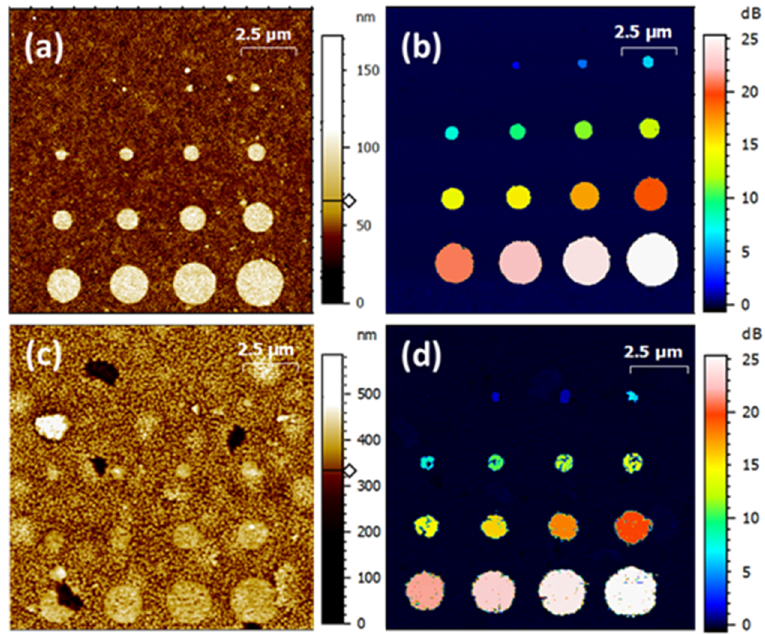
Figure 4. Tapping mode AFM images of ( a ) PZT and ( c ) PMN-PT samples taken with the LNE’s calibrated AFM.  S 11,m magnitude maps of ( b ) PZT and ( d ) PMN-PT samples obtained with calibrated AFM. ∆ S 11,m magnitude maps of ( b ) PZT and ( d ) PMN-PT samples obtained with Keysight’s SMM. Keysight’s